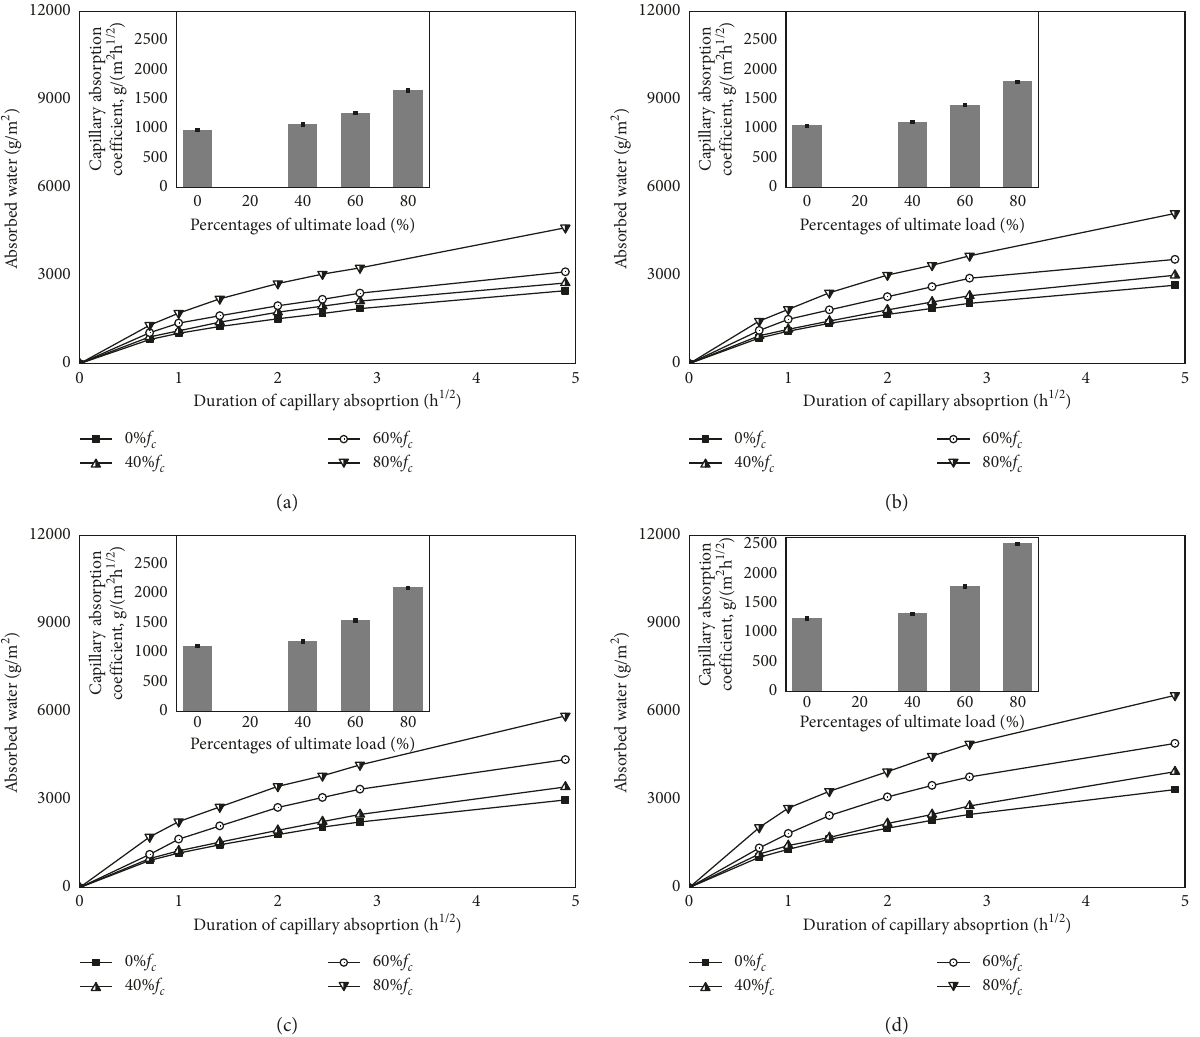
Figure 10: Capillary absorption curves of RAC with different loadings. (a) RAC-0%, (b) RAC-33%, (c) RAC-66%, and (d)